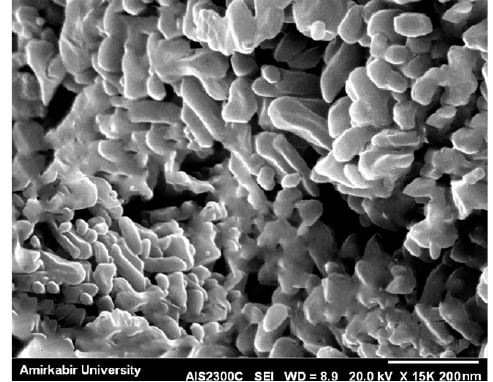
Figure 4. The image of chitosan nanoparticles by SEM. Note . SEM: Scanning electron microscope.